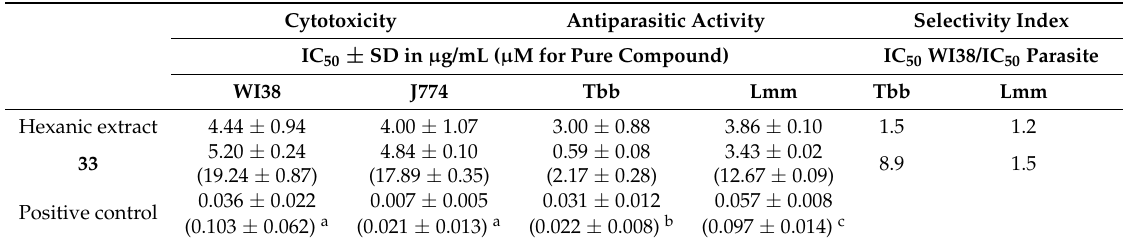
Table 3. The cytotoxicity (WI38 and J774), antitrypanosomal (Tbb) and antileishmanial (Lmm) activities expressed in the IC 50 (Mean ± SD in µ g/mL and µ M for pure compounds from at least six